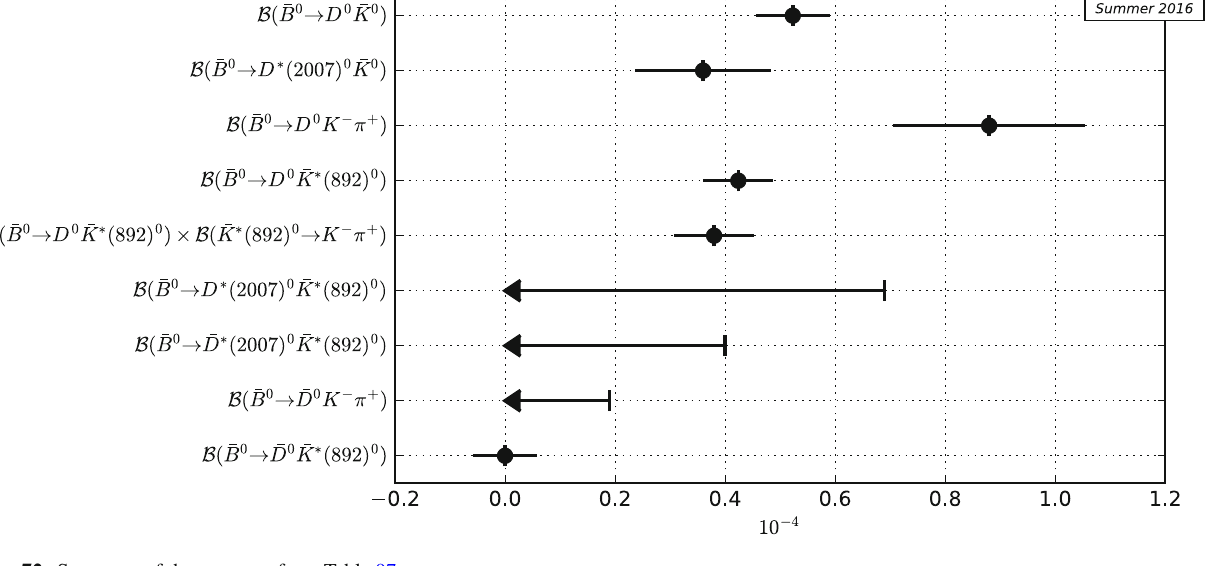
Fig. 72 Summary of the averages from Table 97